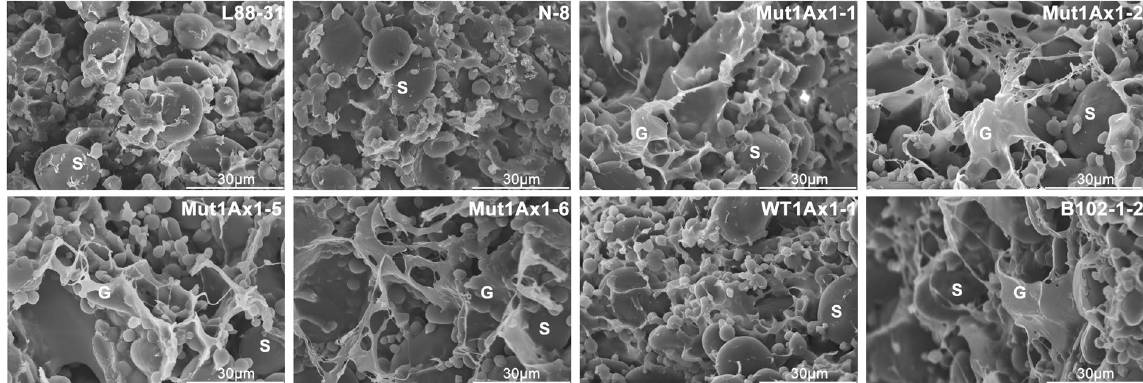
Figure 7. Effects of Mut1Ax1 on the microstructure of dough mixed to peak by SEM. Displays of the starch granules (S) and the gluten network structures (G).